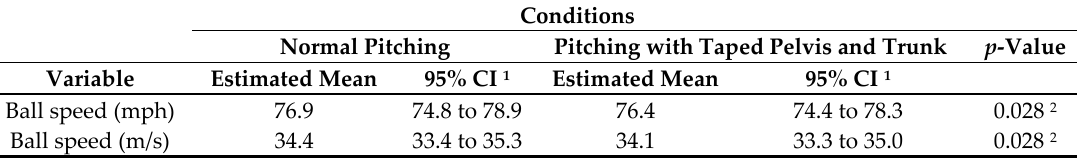
Table 1. Ball speed for the conditions normal pitching and pitching with taped pelvis and trunk estimated with GEE (N =